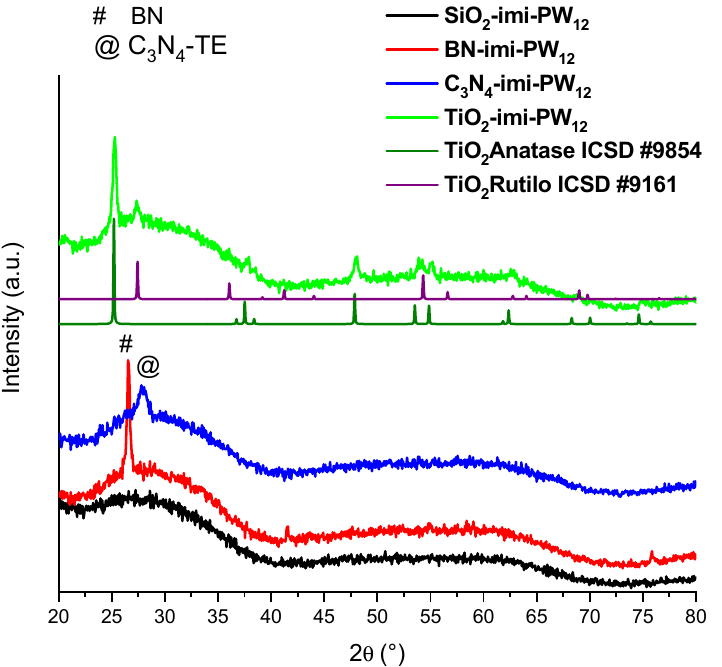
Figure 1. XRD patterns of the functionalized materials along with those of TiO 2 , both anatase and rutile.